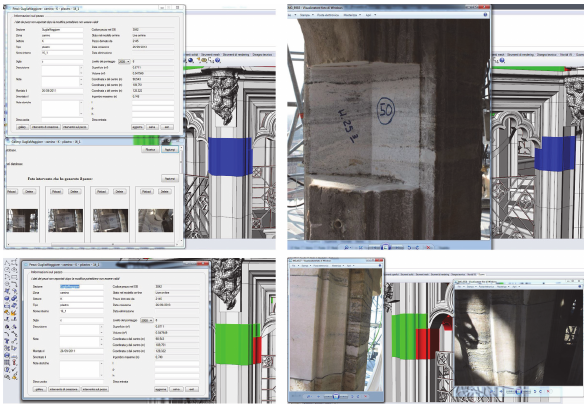
Figure 7. Colour code for interventions.